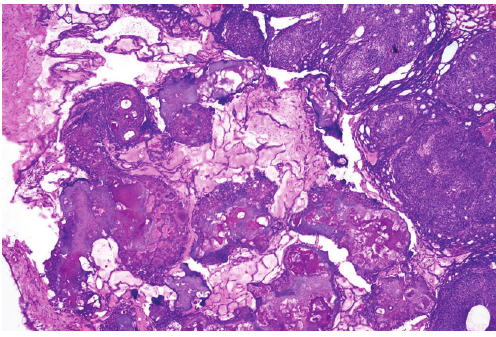
Figure 2: Unicystic ameloblastoma. Epithelial lining shows basal rim of dark staining palissading cells and subepithelial hyalinization which both are typical for ameloblastoma.